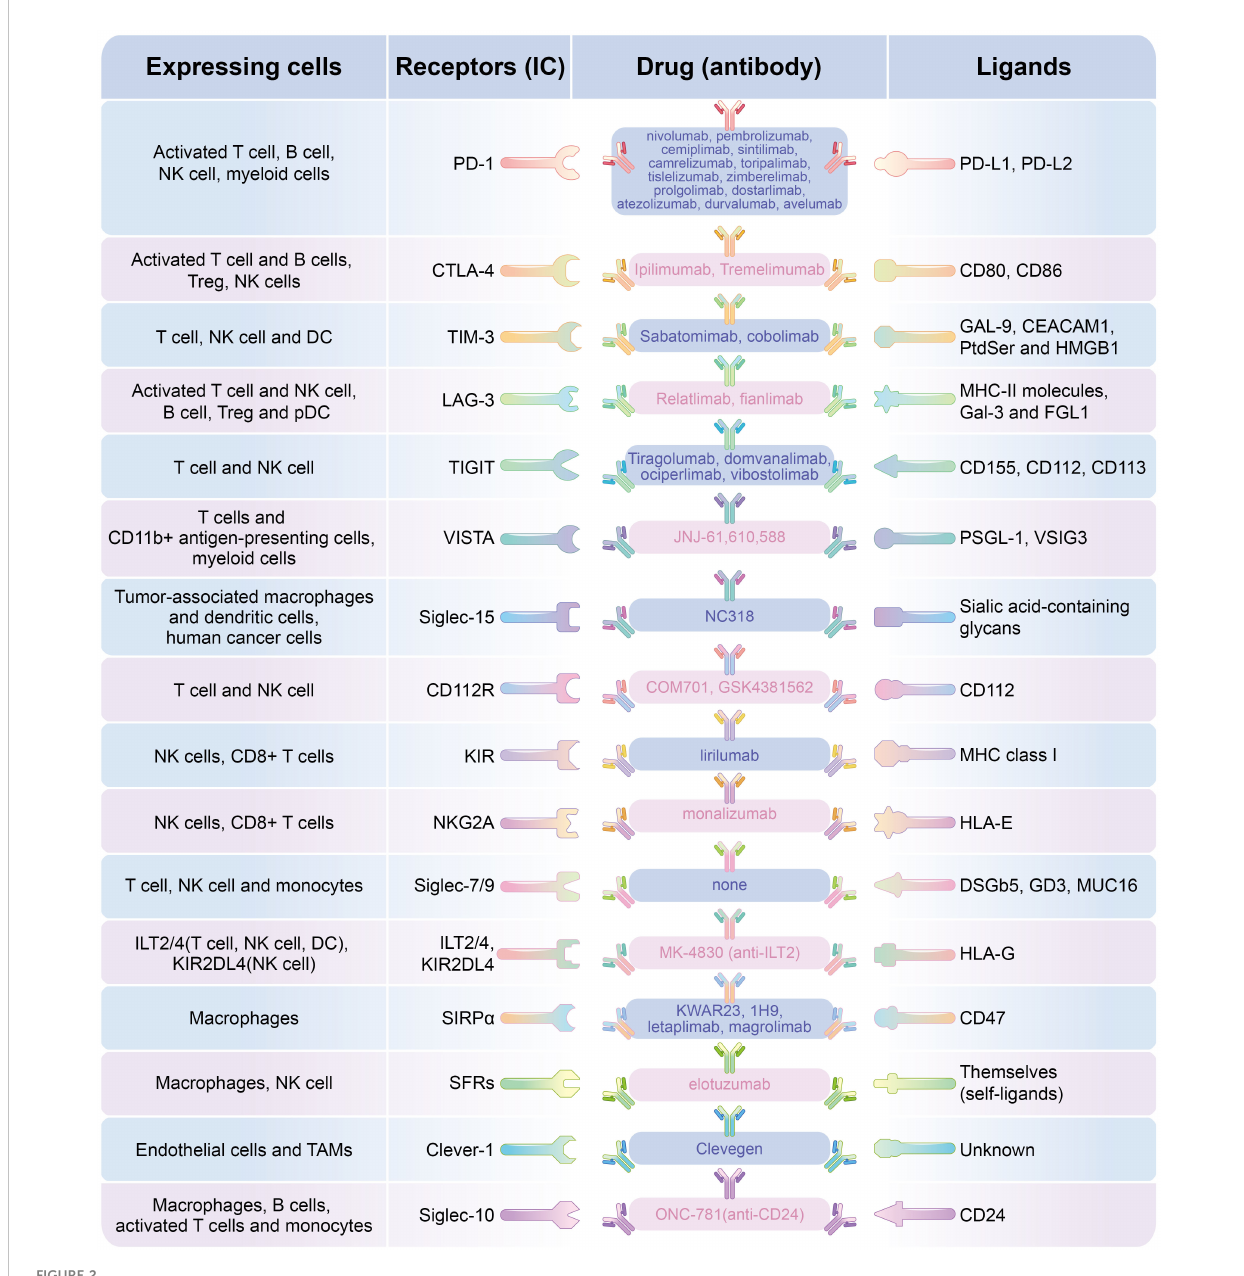
FIGURE 2 Different ICs expressing on different lymphocytes and and the targeted blocking